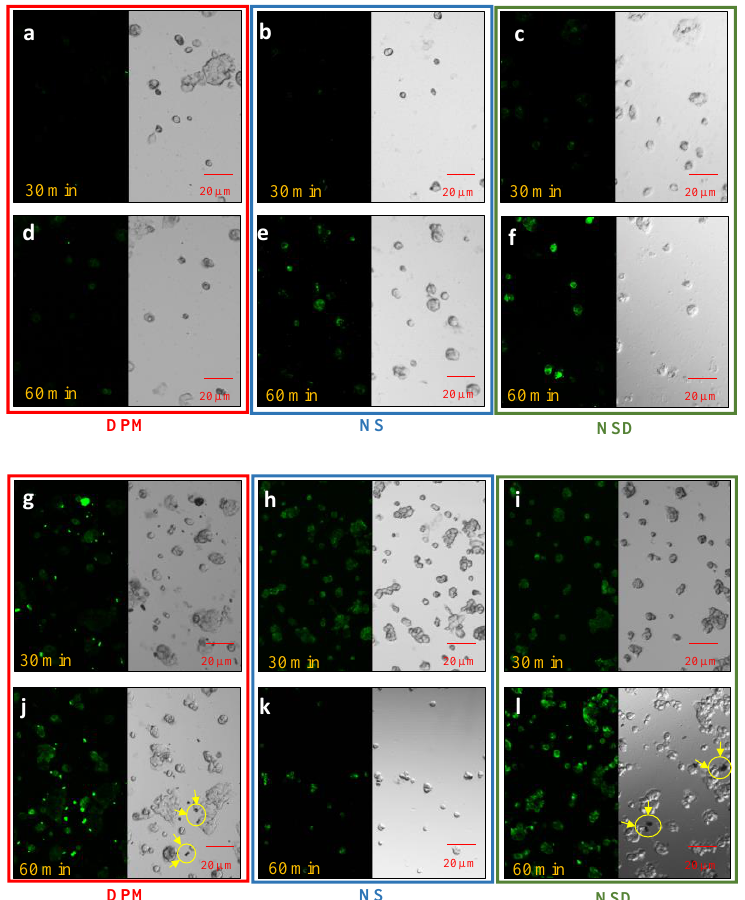
Figure 5. CLSM images of Caco-2 cells after incubation with DPM, NS, and NSD at 25 µg/mL (image a – f ) and 50 µg/mL (image g – l ), respectively for 30 and 60 min. Left side shows the fluorescence of DPM in the laser beam and the right side shows the phase-contrast images. Images ( a , d , g , j ) represent DPM; images ( b , e , h , k ) represent NS and; images ( c , f , i , l ) represent NSD. Encircled zones with arrows indicate particles/agglomerates observed outside the cells.